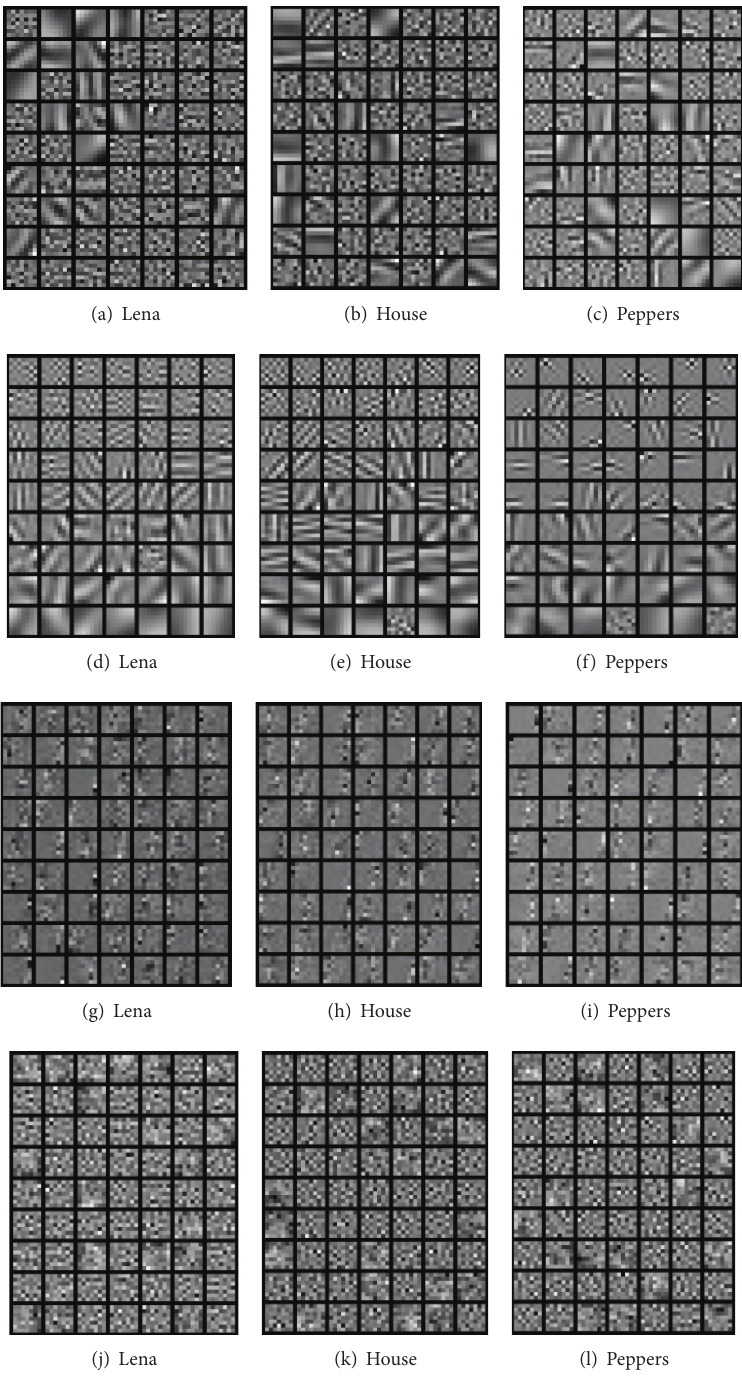
Figure 3: The learned dictionaries of size 63 × 49 by using the OIHT-ADL, AK-SVD, NAAOLA, and LOST algorithms on the three images with noise level 𝜎 = 5 . The results of the OIHT-ADL are shown in the top row in (a) Lena, (b) House, and (c) Peppers, followed by the AK-SVD, NAAOLA, and LOST in the remaining